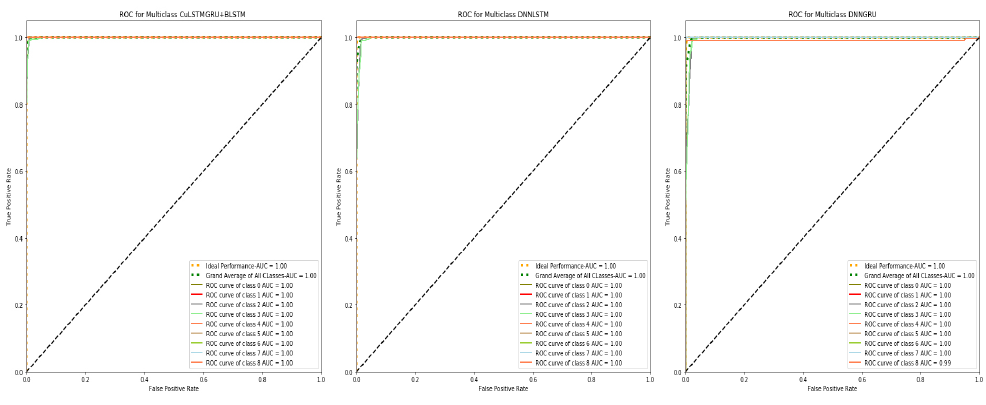
Figure 3. ROC curves of the models.